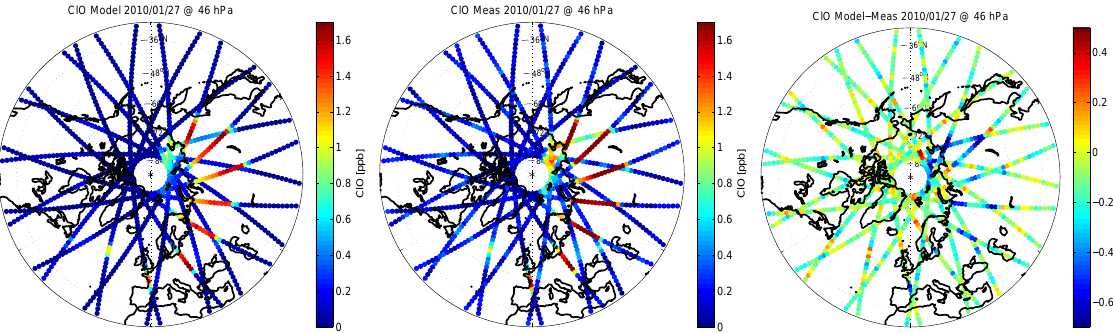
Fig. 2. Modelled (left) and measured (middle) ClO mixing ratios at the MLS layer centred at 46hPa along the satellite tracks of 27 January. The right panel shows the differences. Backward trajectories starting at the satellite measurements and ending at the time of the last model output before the measurement were calculated. Then, a chemical box model was initialised with the model data and the evolution of the species was calculated forward in time to obtain values to compare with the satellite